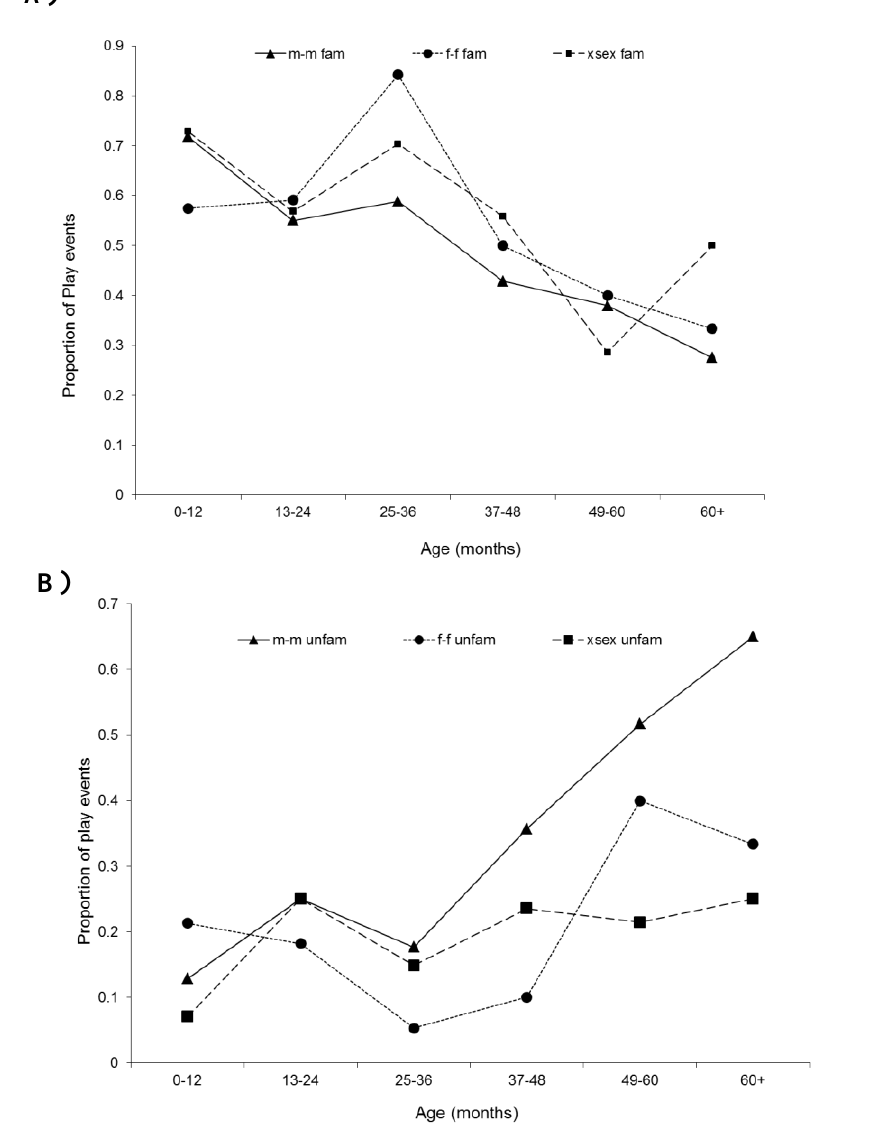
Figure 5. The proportion of play partners that were matched for sex and familiarity; ( A ) Family partners, ( B ) Unfamiliar non- family play partners (m-m = male play with male; f – f = female play with female; xsex = across sex; fam = family; unfam =